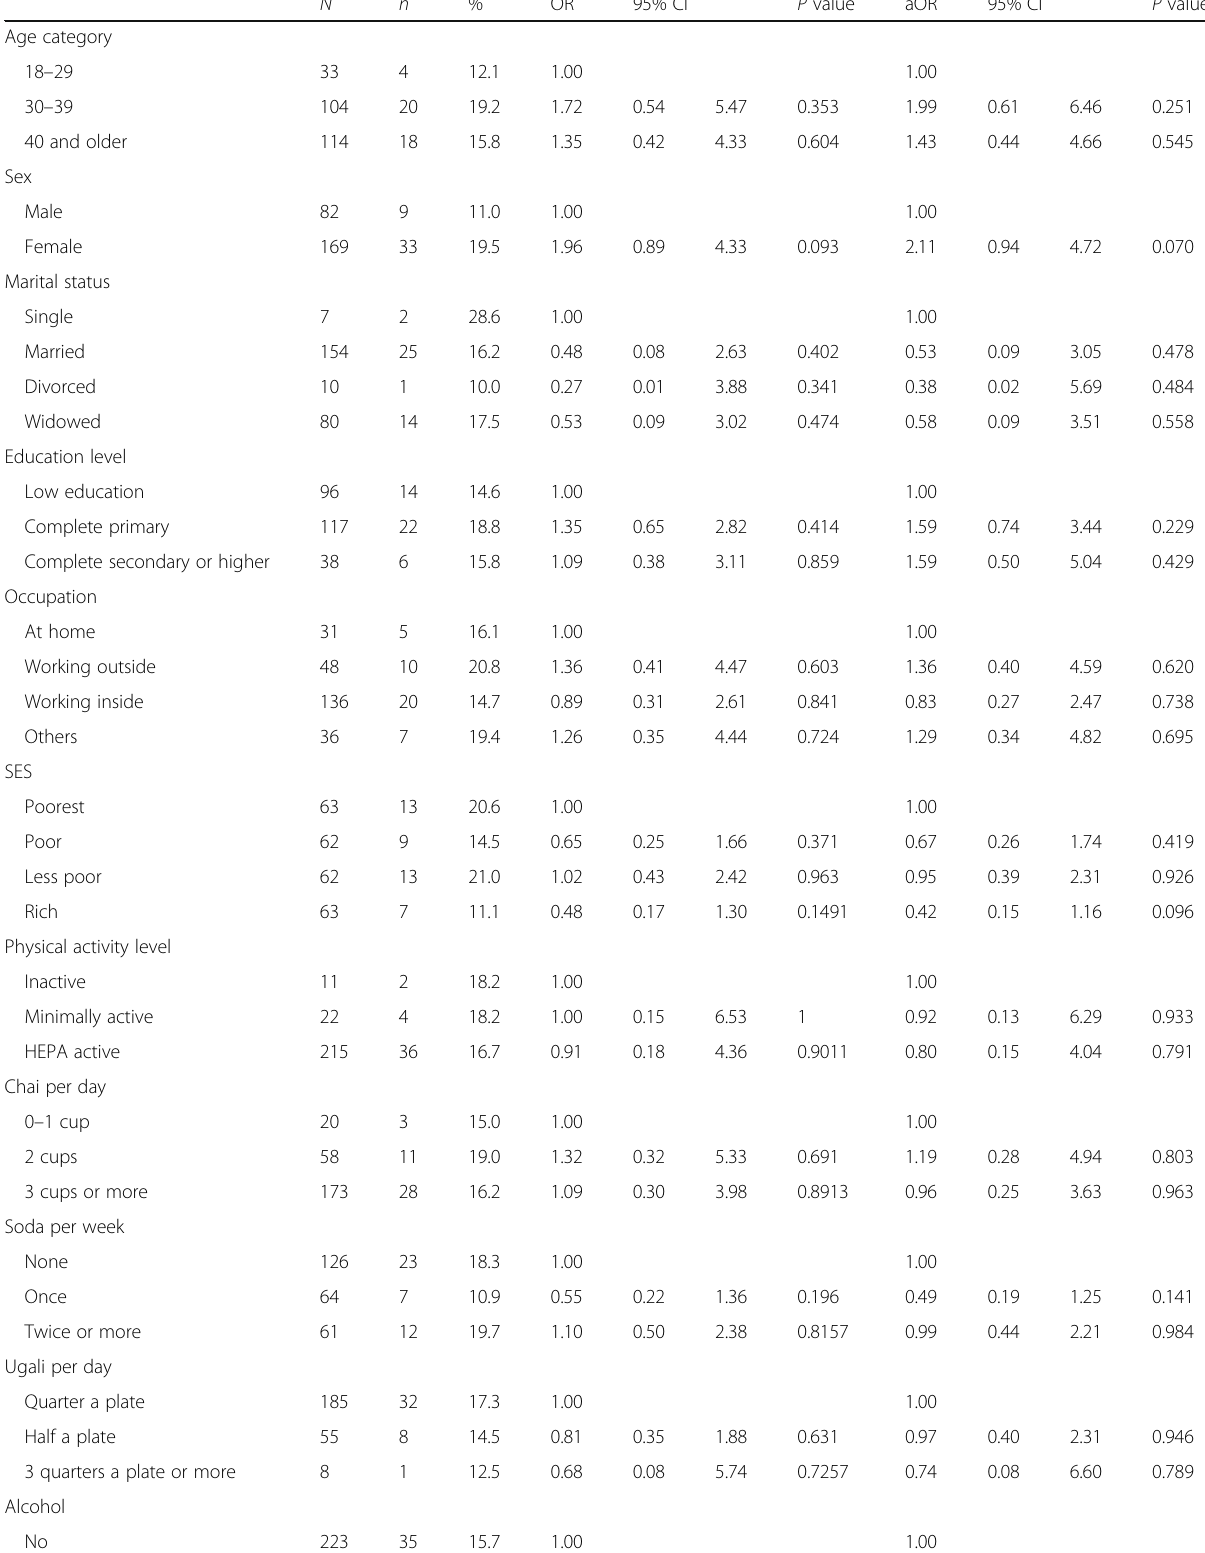
Table 3 Factors associated with